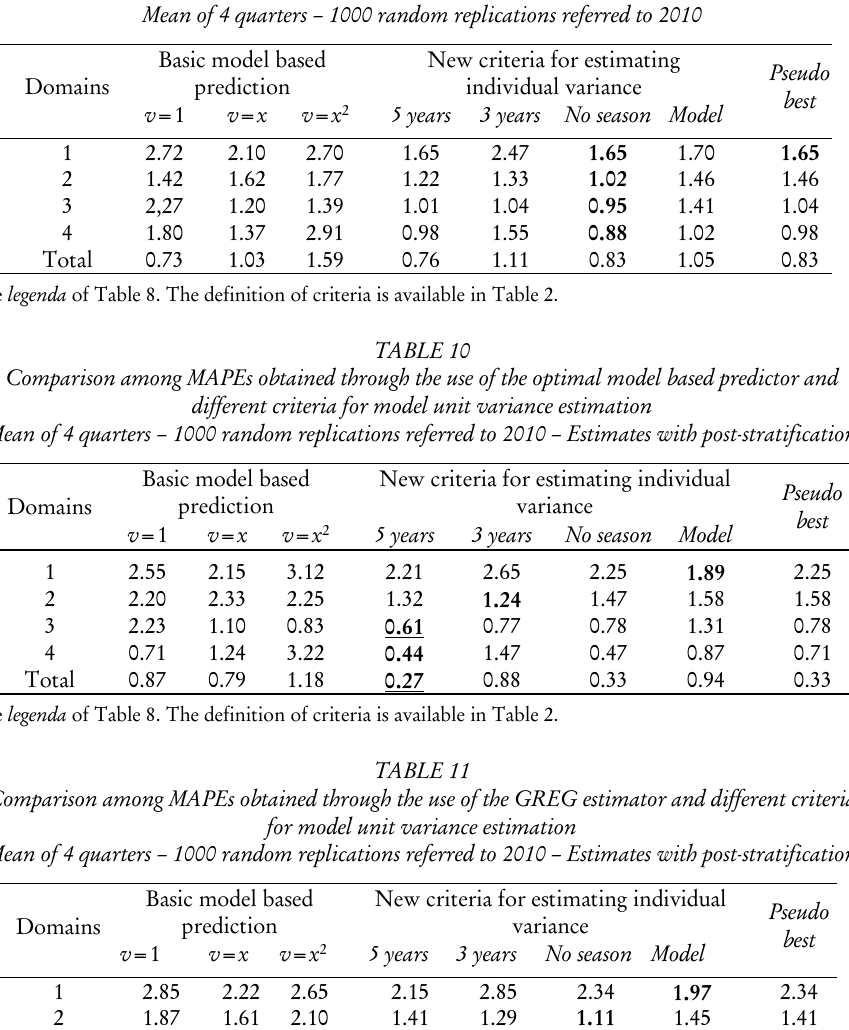
Comparison among MAPEs obtained through the use of GREG estimation and different criteria for